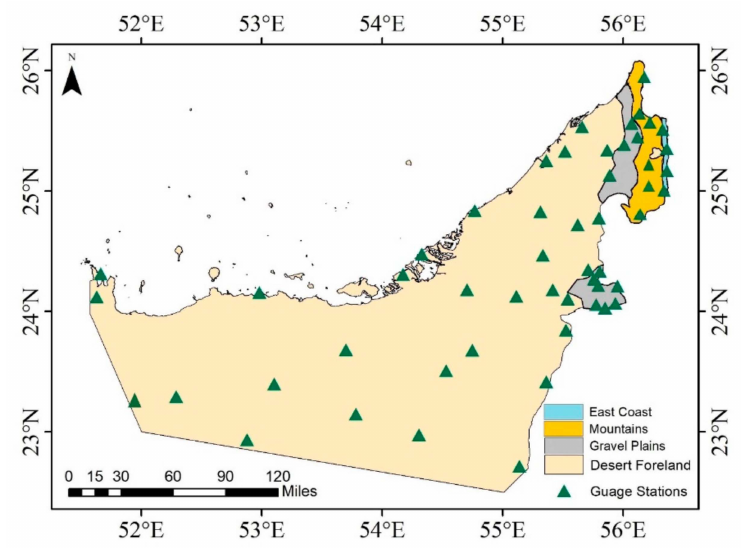
Figure 1. The study area including the geomorphological regions and locations of rain